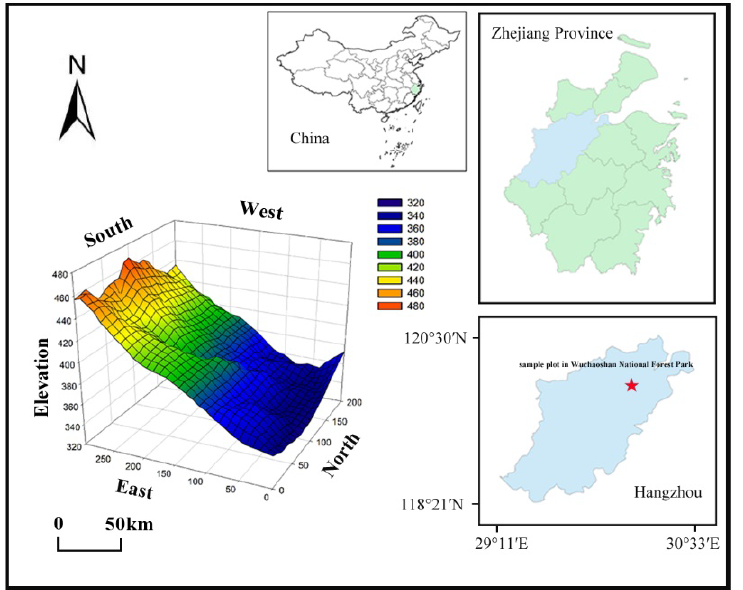
Figure 1. Location and topographic map of the forest dynamic monitoring plot in Wuchaoshan National Forest Park reprinted/adapted with permission from Ref. [17]. 2022, Liangjin Yao.